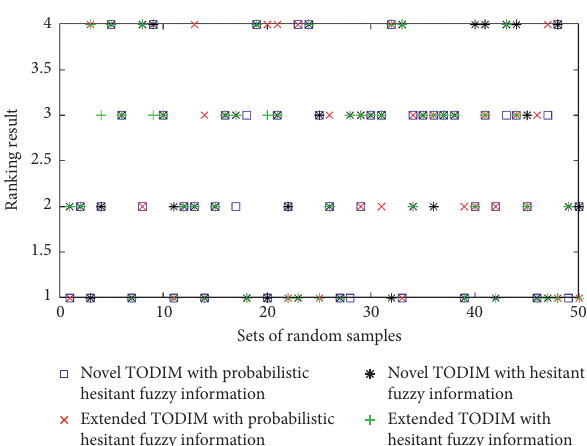
Figure 12: Ranking results of the alternative A samples).